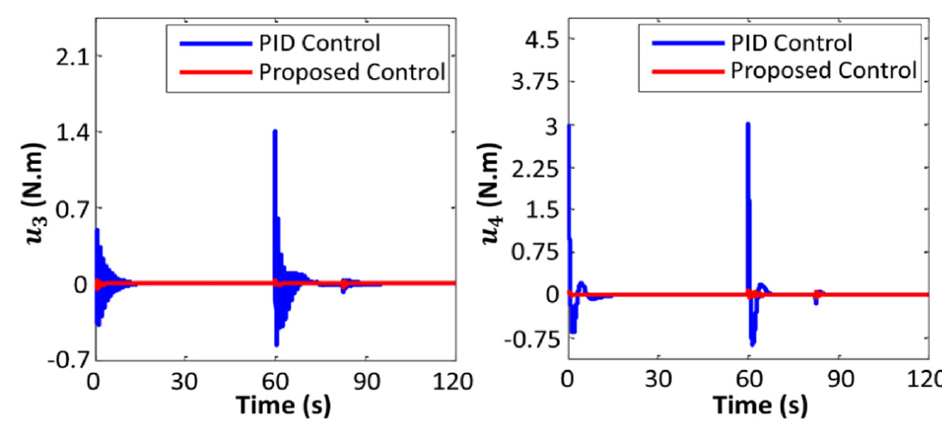
Figure 12. Variations in manipulated variables u 3 and u 4 .